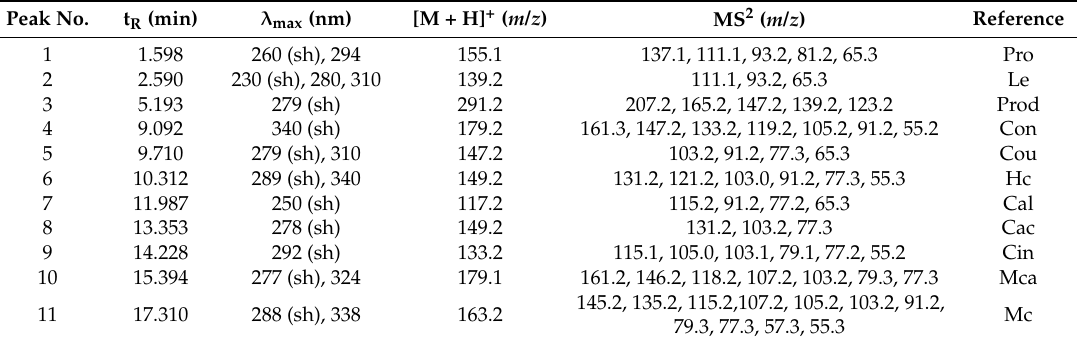
Table 1. Identification of eight phenylpropanoids and three phenolic in Chinese Cinnamomi cortex using UPLC–DAD and